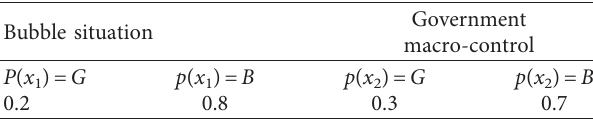
Figure 1: Schematic diagram of the Bayesian network correction process of the aviation industry development. Table 2: Expert prediction probability table of the economic de- velopment and government regulation effect in September 2019.